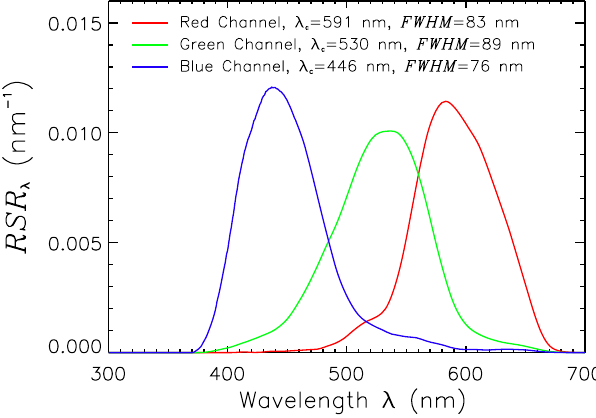
Fig. 2. Relative spectral response function RSR λ of the three cam- era channels (red, green, blue). For each channel, the center wave- length (median value) λ c and the FWHM are